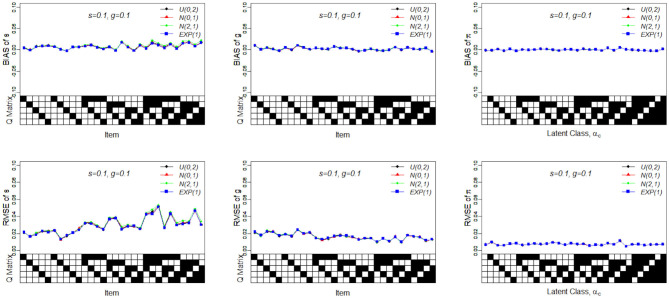
Bias and RMSE of slip, guessing and the latent membership parameters based on different non-conjugate priors. Given on the X-axis are the Q-matrix and αc, where a black square denotes the presence of the attribute.